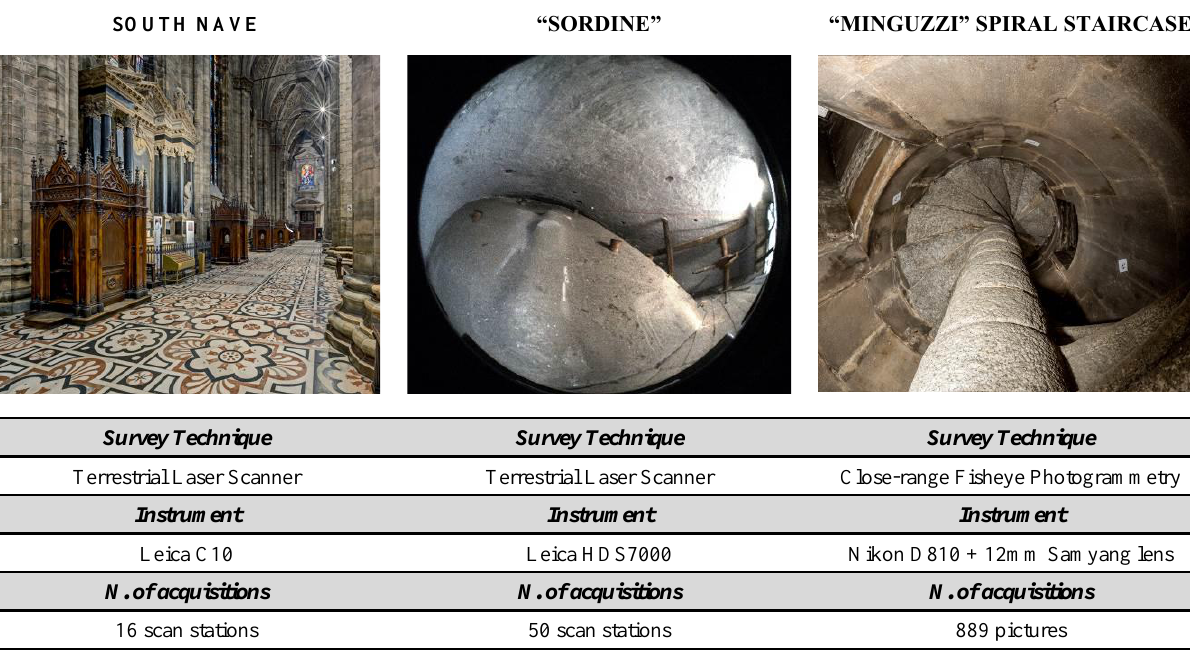
Figure 2. Milan Cathedral test areas with survey techniques used.